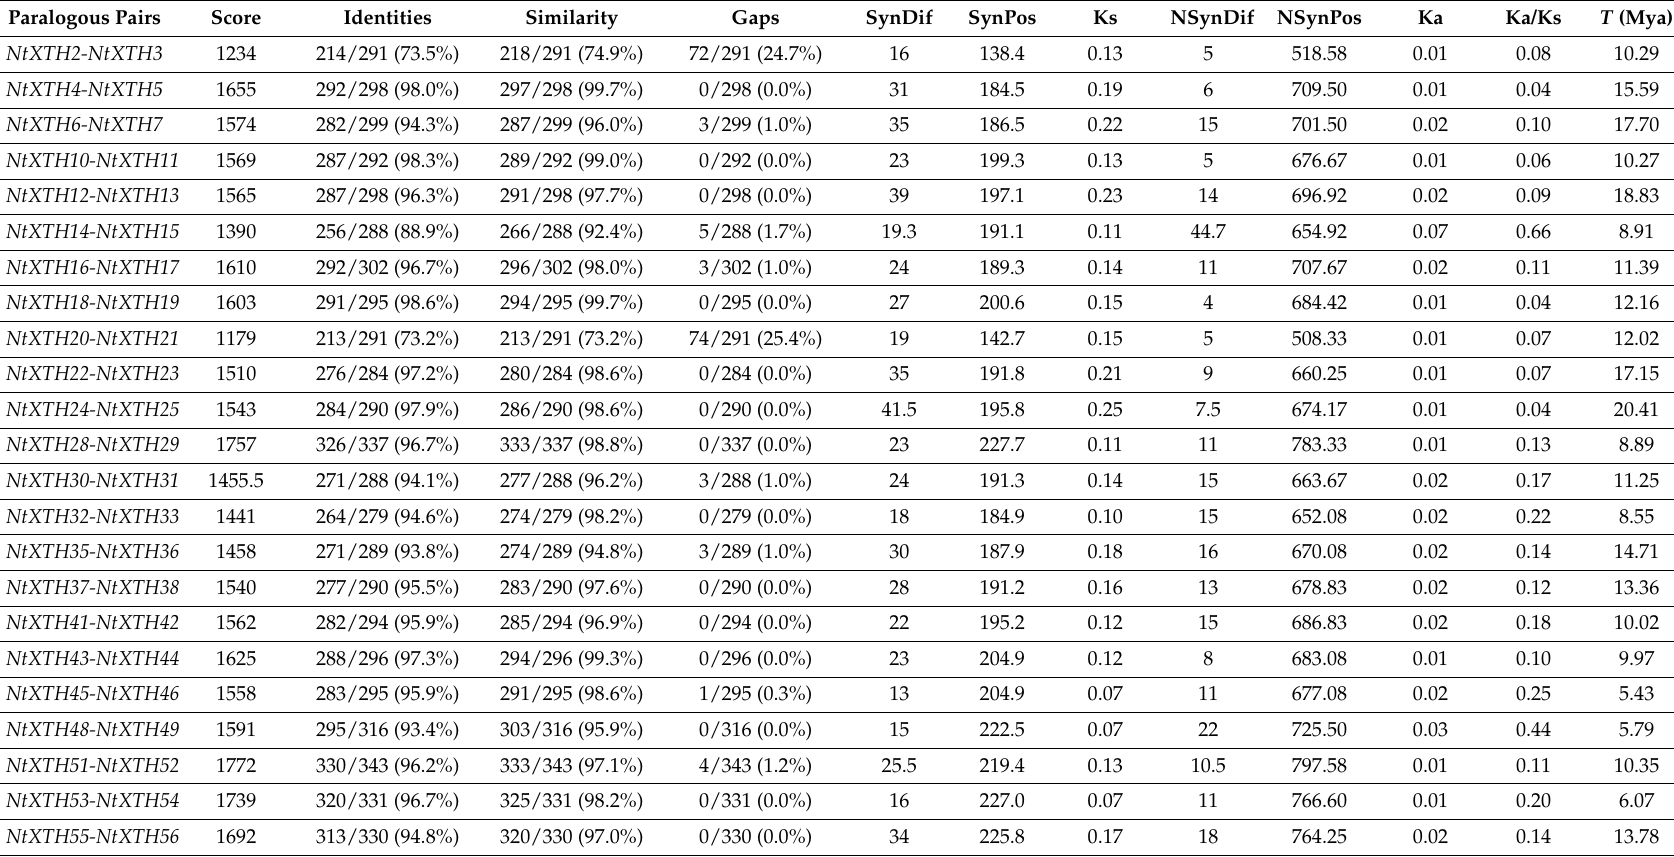
Table 2. Pairwise identities and divergence period estimation of common tobacco XTH